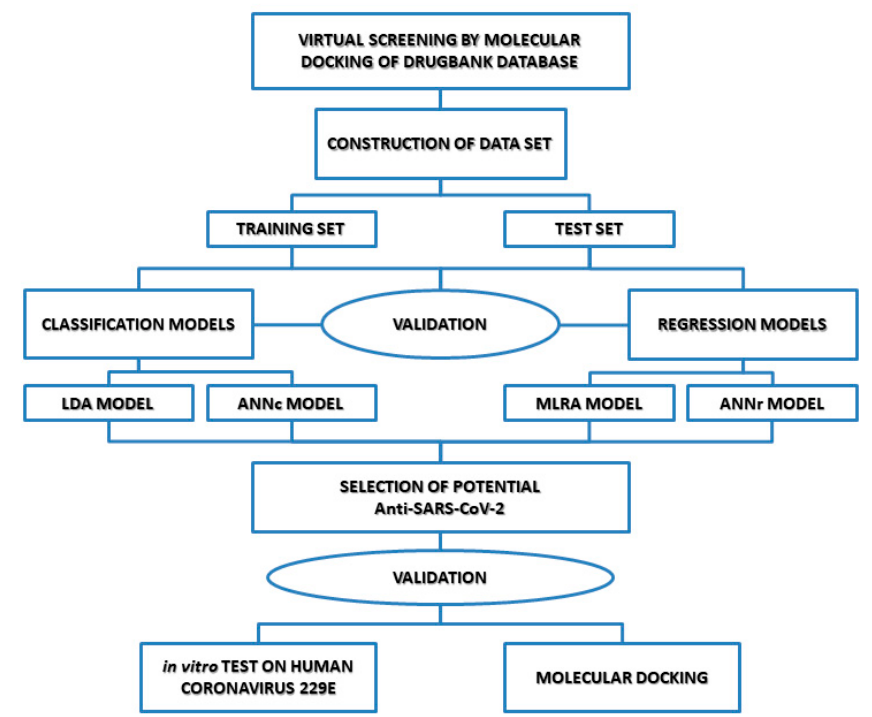
Figure 1. Search algorithm used to develop in silico strategy for the repositioning of potential Mpro inhibitors against SARS-CoV-2.